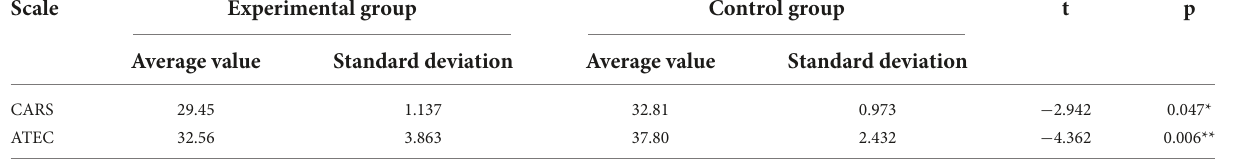
TABLE 4 Independent sample t -test results of CARS and ATEC post-test scores in experimental group and control group.